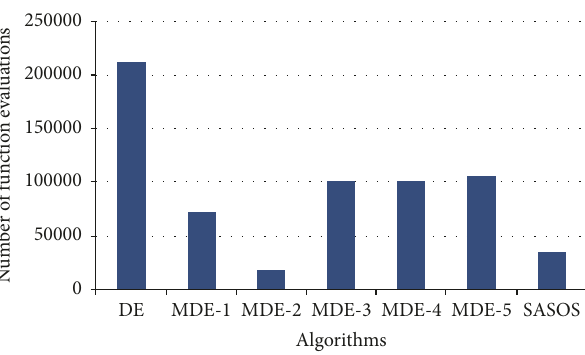
Figure 9: Comparison of best objective values obtained by SASOS algorithm with DE and its modified versions for 6-bus